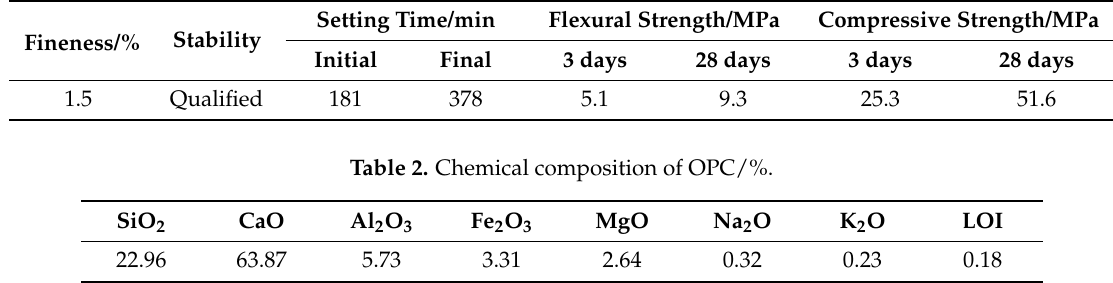
Table 1. Physical properties of ordinary Portland cement (OPC).